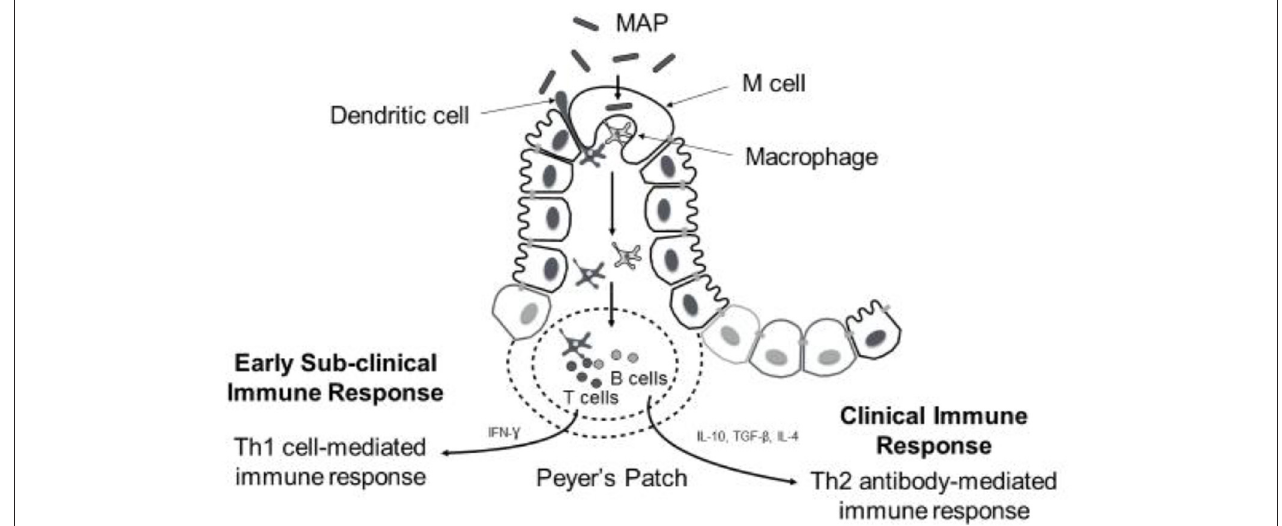
FIGURE 1 | Diagrammatic representation of MAP uptake and immune response during disease progression. Following oral ingestion of MAP, M cells facilitate uptake of MAP across mucosal epithelium into submucoal gut-associated lymphatic tissue (peyer’s patches). Here MAP is phagocytozed by macrophages (sometimes dendritic cells can sample MAP from intestinal lumen directly). Early immune response against MAP infection involves activation of macrophages and T-cells to promote Th1 cell-mediated immune response. Predominance of cell-mediated immune response is observed during subclinical stage of the disease; however, the onset of clinical signs coincides with shift from Th1- to- Th2 antibody-mediated immune